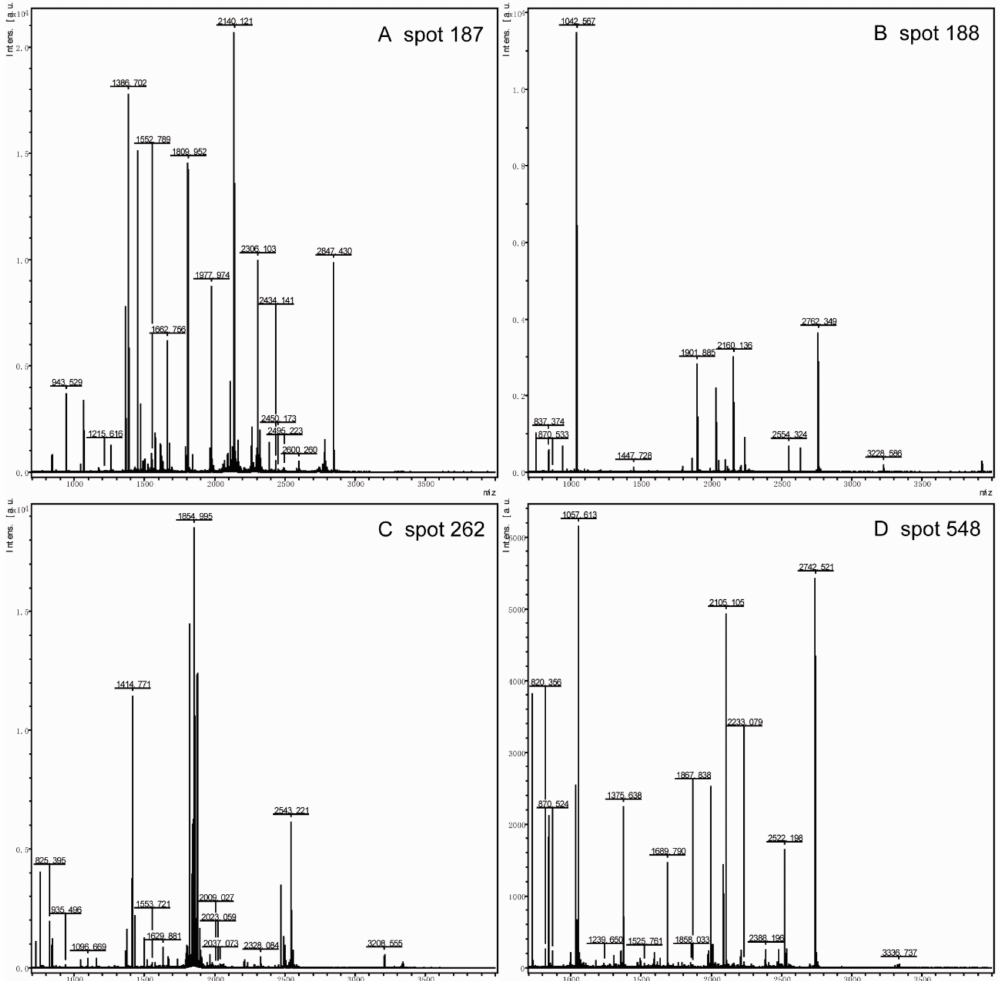
Figure 4. The mass spectrum of Spot 187 ( A ), Spot 188 ( B ), Spot 262 ( C ), and Spot 548 ( D ) in the 2-DE gel map of the wild-type yeast strain BY4741. Spot 187 was identified as Ssa1; Spot 188, Spot 262, and Spot 548 were identified as Fba1p, Eno2p, and Pdc1p,